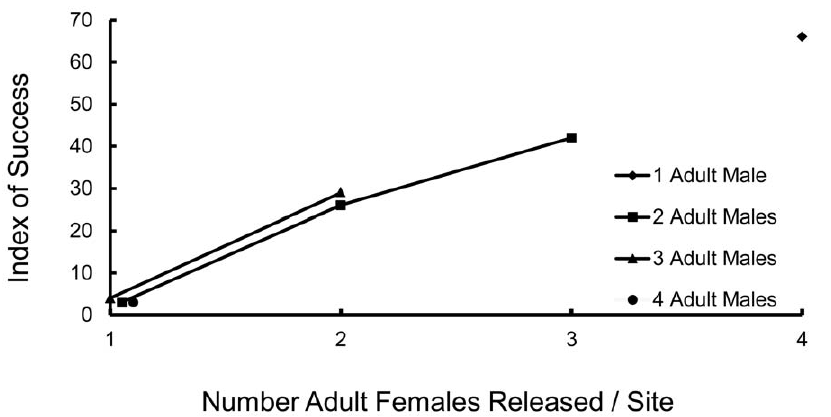
Figure 2. Predicted relationship between numbers of adult female and adult male fishers released and reintroduction success. Fishers were released at each of 4 subsites in each of 5 years. No juvenile fishers were released in these scenarios. The VORTEX model included stochastic variation and was run for 100 years. Twenty fishers were modeled to be released each of 5 years in 4 groups of 5, with each group released into a different site.